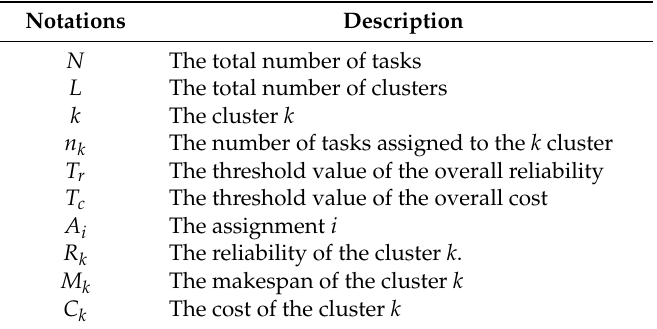
Table 1. The descriptions of notation in the cluster selection